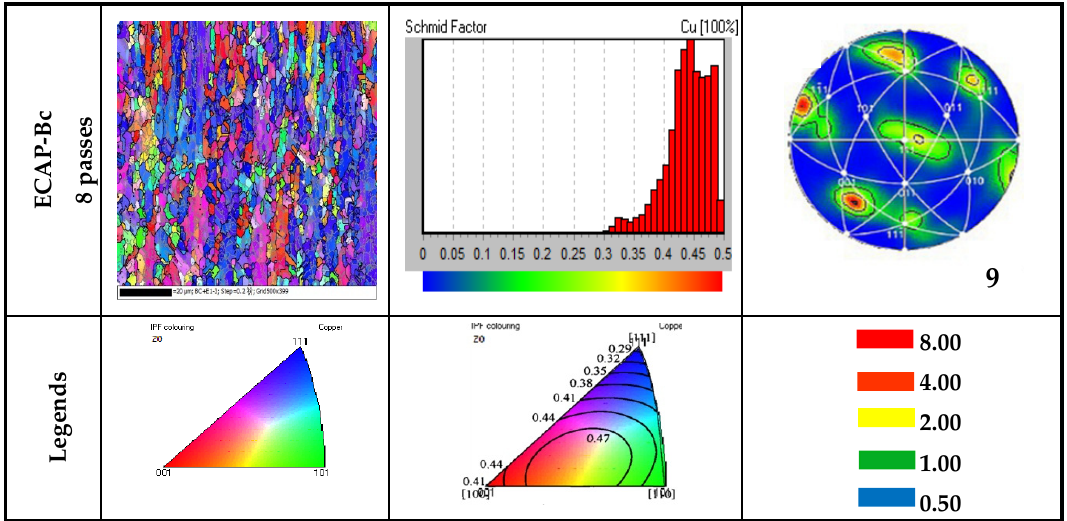
Figure 1. Contrast map, Schmid Factor, {111} pole figure for different passes of ECAP by route Bc.